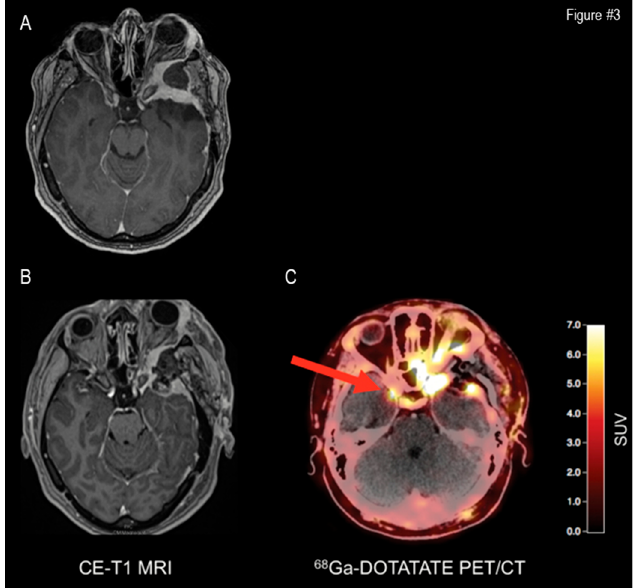
Figure 3. Additive value of SSTR-PET to MRI in restaging. A 42-year-old patient with a history of a left sphenoid skull base meningioma. Preoperative MRI shows tumour recurrence (Panel A). Postoperative MRI (Panel B) shows an incomplete resection of the tumour, necessitating adjuvant radiotherapy. 68Ga-DOTATATE PET/CT reveals an additional meningioma located at the tip of the right sphenoid wing (Panel C). Reprinted with permission from Galldiks et al. [78].